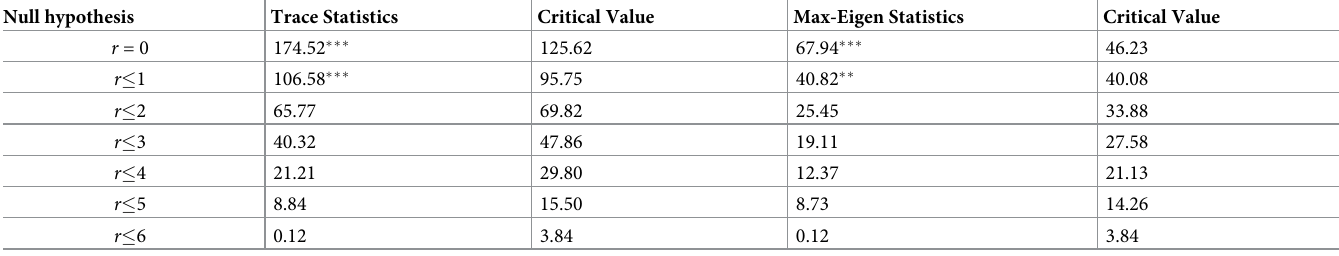
Table 3. Results of cointegration test.